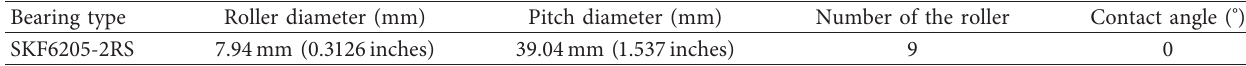
Figure 15: Detailed description of bearing fault states. Table 4: The specification of test bearing.